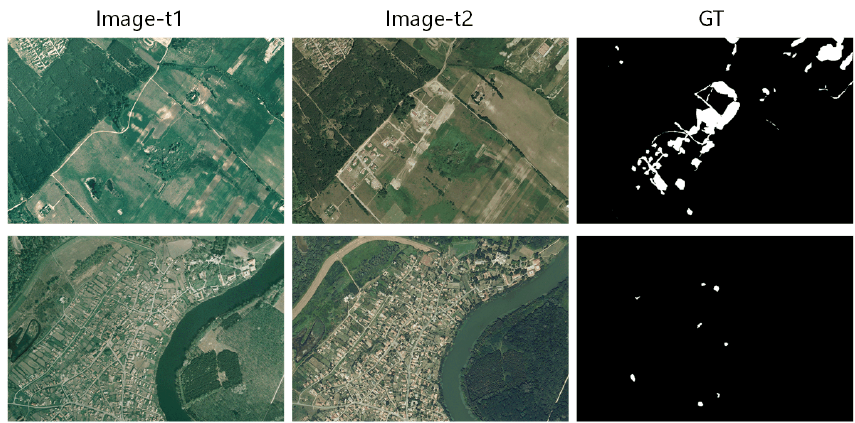
Figure 4. Illustrations of samples from SZTAKI. The change highlighted by white pixels contains new built up regions, building operations, planting forests, fresh plough-lands and also groundwork before building